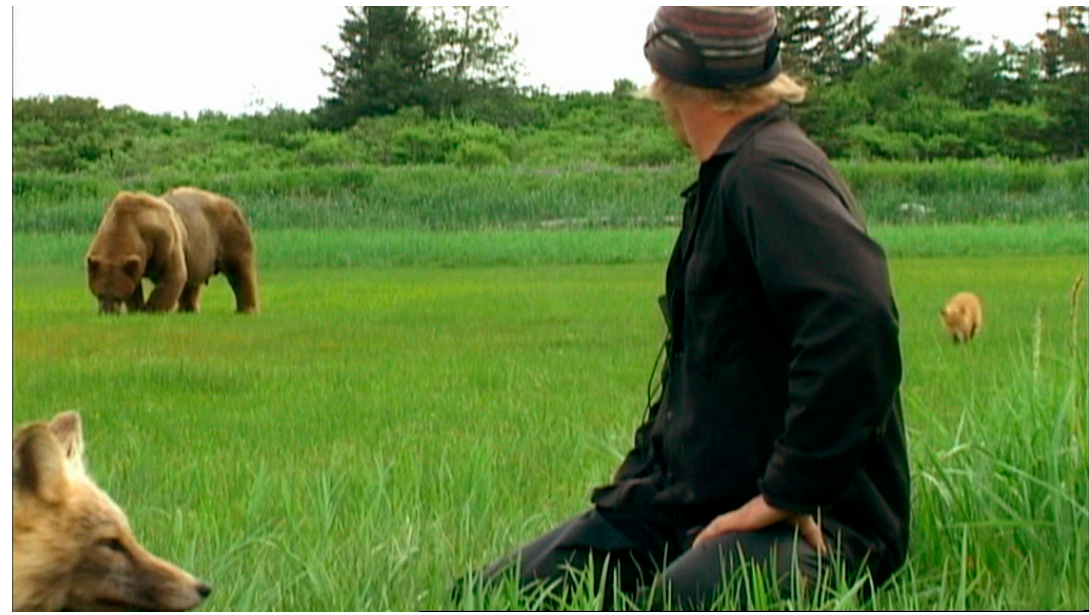
Figure 2. Bear, foxes, Timothy Treadwell.